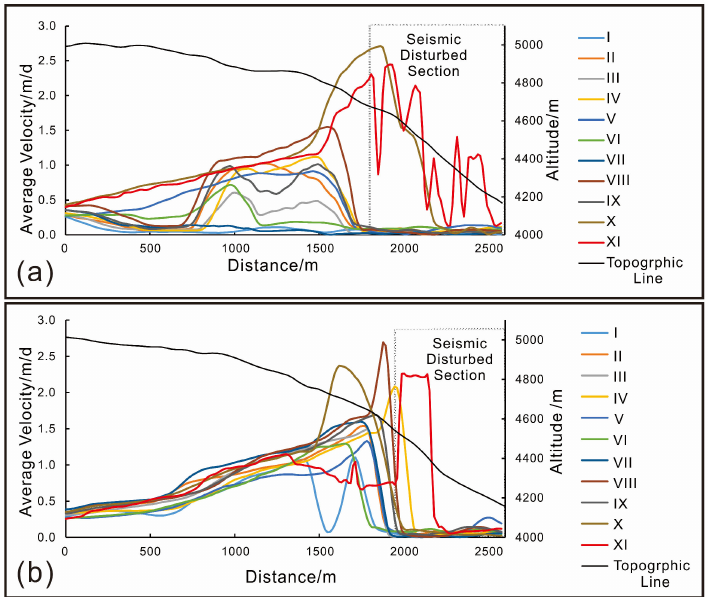
Figure 11. Average glacier moving velocities of the ( a ) 1-1’ and ( b ) 2-2’ profile